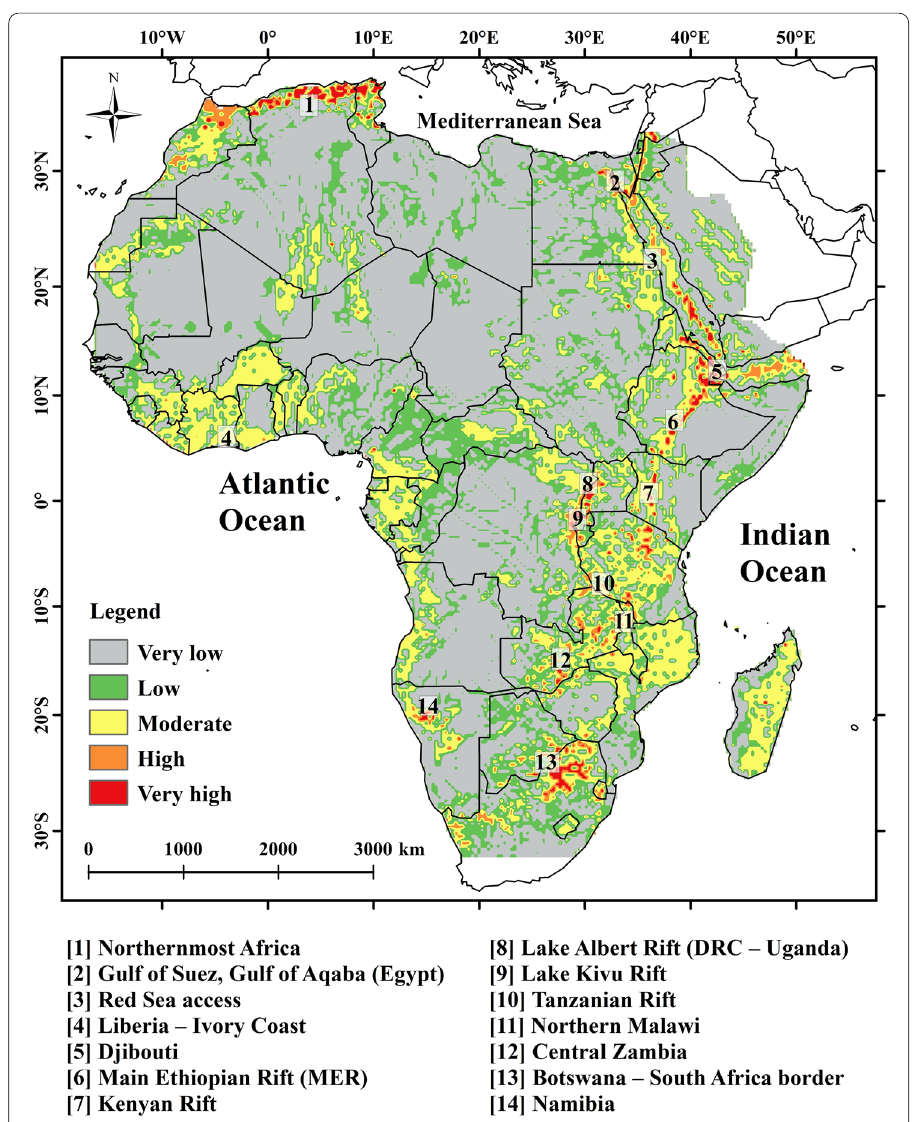
Fig. 7 Geothermal potential map of Africa derived from the weighting of overlays, each representing analyses of thematic layers. The map identifies 14 areas with high geothermal potential that might be exploited for more geothermal investigation and